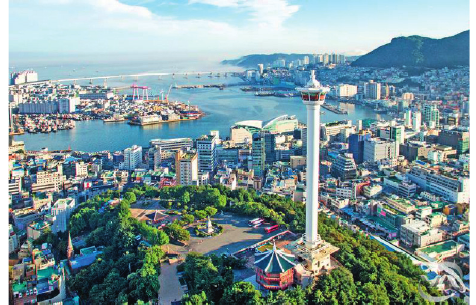
Figure 1: Busan tower.